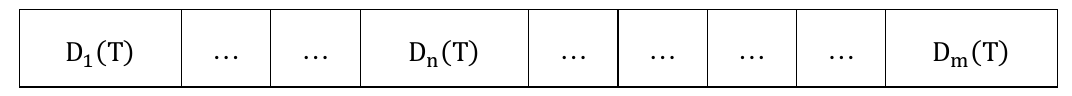
Figure 5. Datasets with missing data.